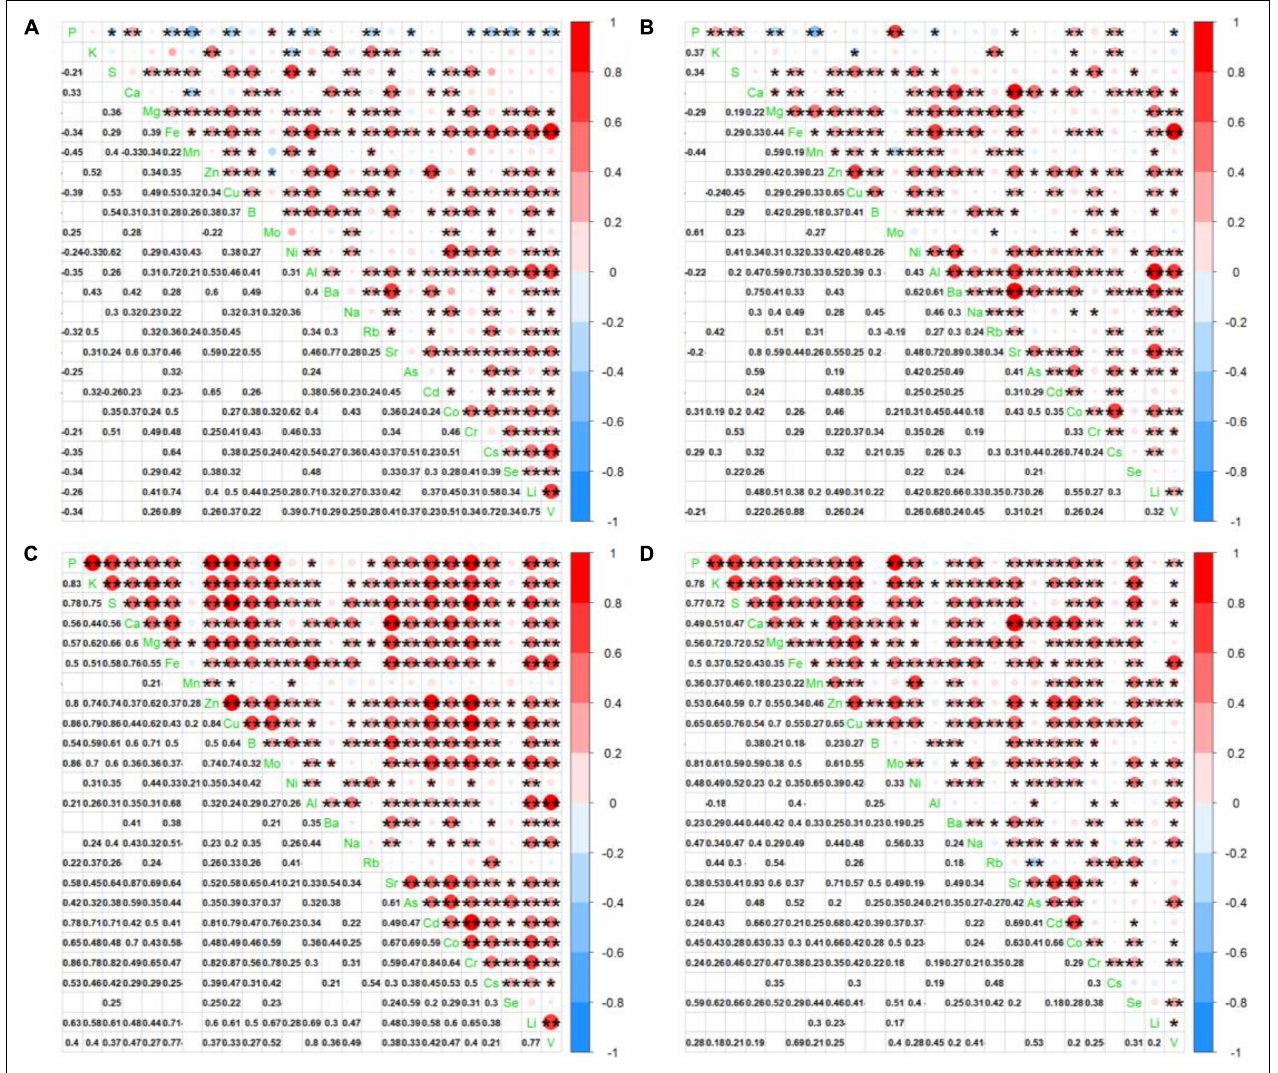
FIGURE 4 | Heatmap showing correlation coefficients among leaf elements in the families (A) Rosaceae, (B) Asteraceae, (C) Fabaceae, and (D) Poaceae.